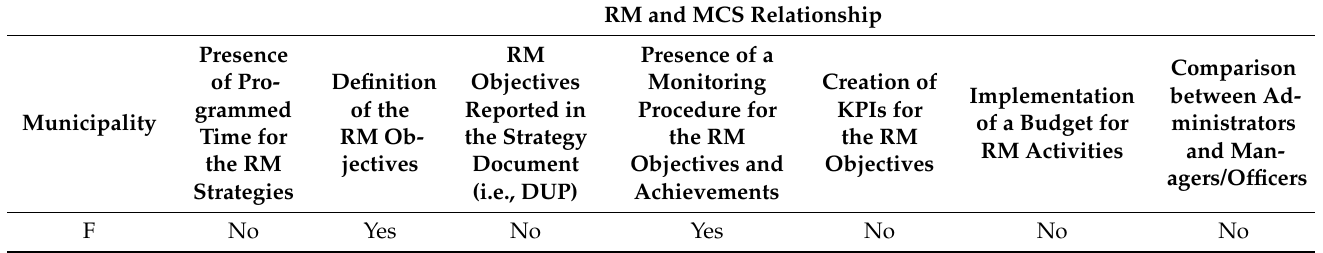
Table 8. Responses about risk management and the management control system relationship in Municipality